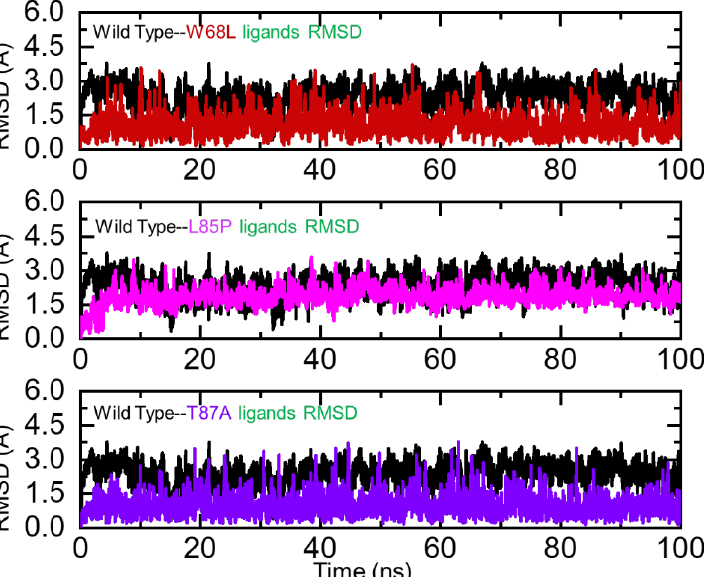
Figure 3. Ligand stability analysis in the binding cavity of the wildtype and W68L, L85P, and T87A mutants. The wildtype is shown as black, W68L (red), L85P (magenta), and T87A (purple).